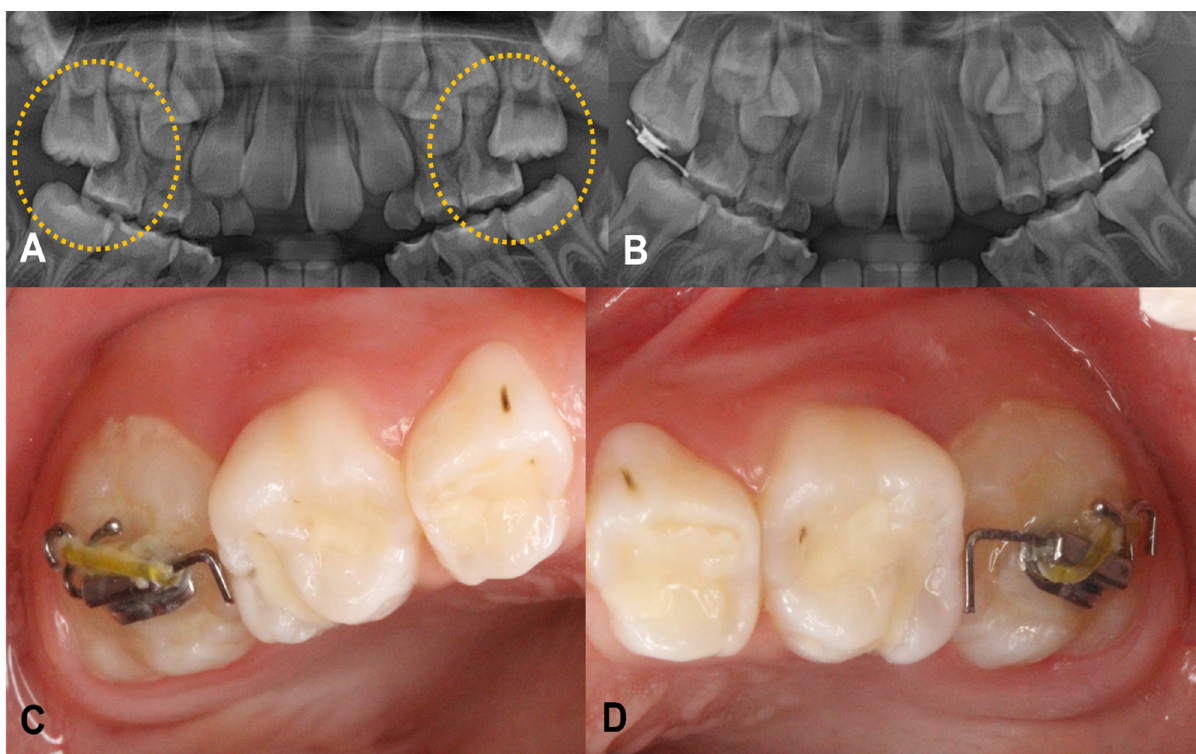
Figure 2. A 6-year-old girl showed ectopically erupting permanent maxillary right and left first molar. ( A ) Severe resorptions of the distal root of maxillary primary molars on both sides were observed on panoramic view. ( B ) Result of piston-elastic, 3 months after the attachment. ( C , D ) Intraoral photograph of the device.